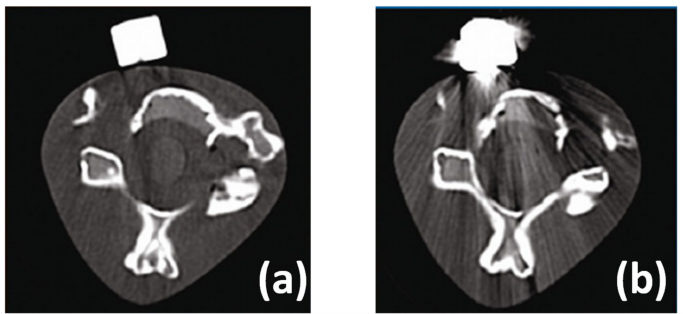
Figure 7. CT images ( a ) with a PEEK-OPTIMA image contrast grade and ( b ) with a metallic implant. Reproduced with permission from [46]. Copyrigth 2019,